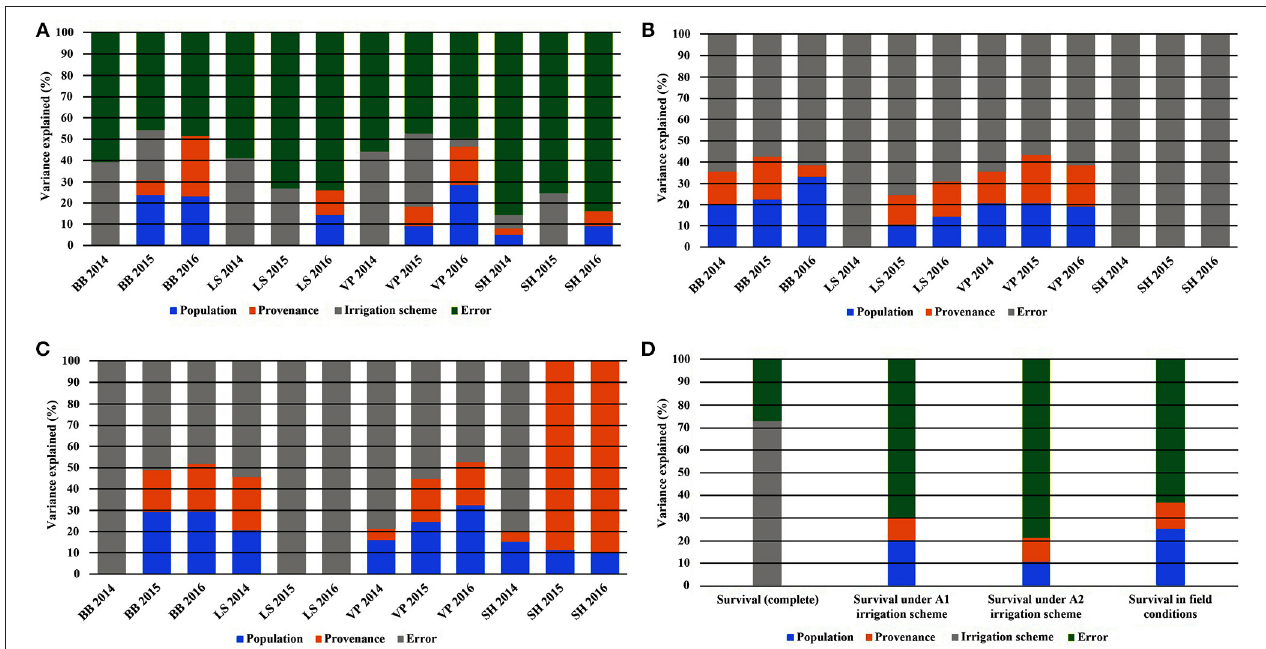
FIGURE 5 | Partitioning of variance across the years of the study for the traits of leaf phenology* and seedling height overall (A) , under irrigation scheme A1 (B) , under irrigation scheme A2 (C) , and for seedling survival (D) . *Abbreviations: BB, Bud burst; LS, Leaf senescence; VP, Growing period; SH, Seedling